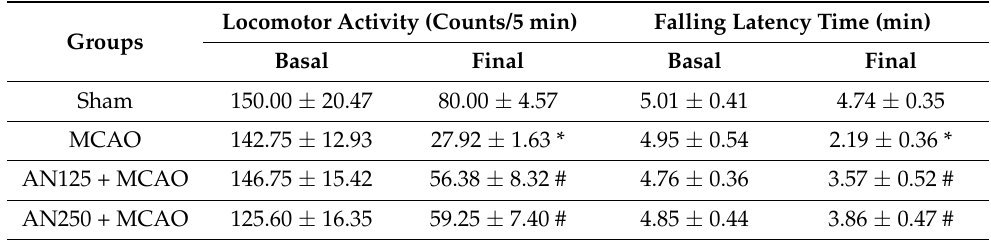
Table 1. The impact of pretreatment with anethole (AN, 125, 250 mg/kg, orally) for two weeks in MCAO-induced cerebral ischemia/reperfusion in rats on spontaneous locomotor activity using the activity cage test and on motor coordination using the rotarod